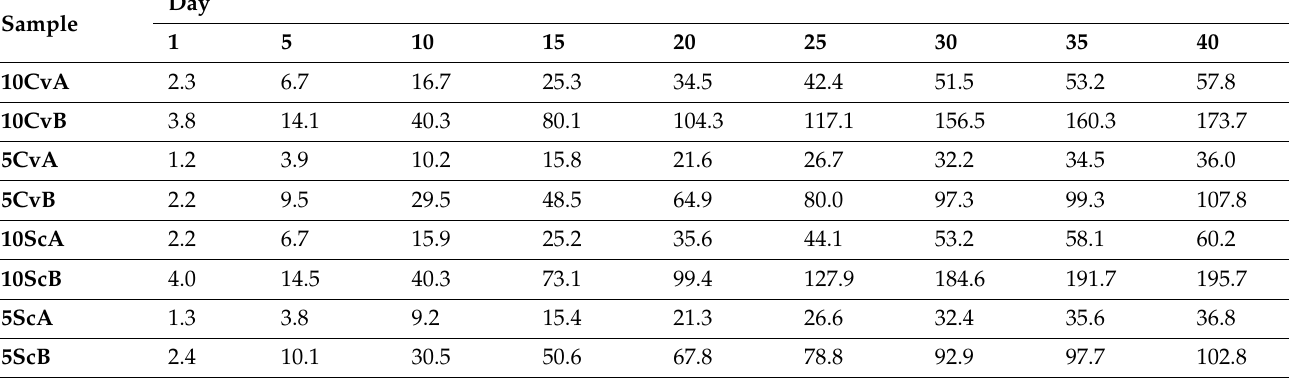
Table 1. Growth rate of microalgal biomass: µ (d − 1